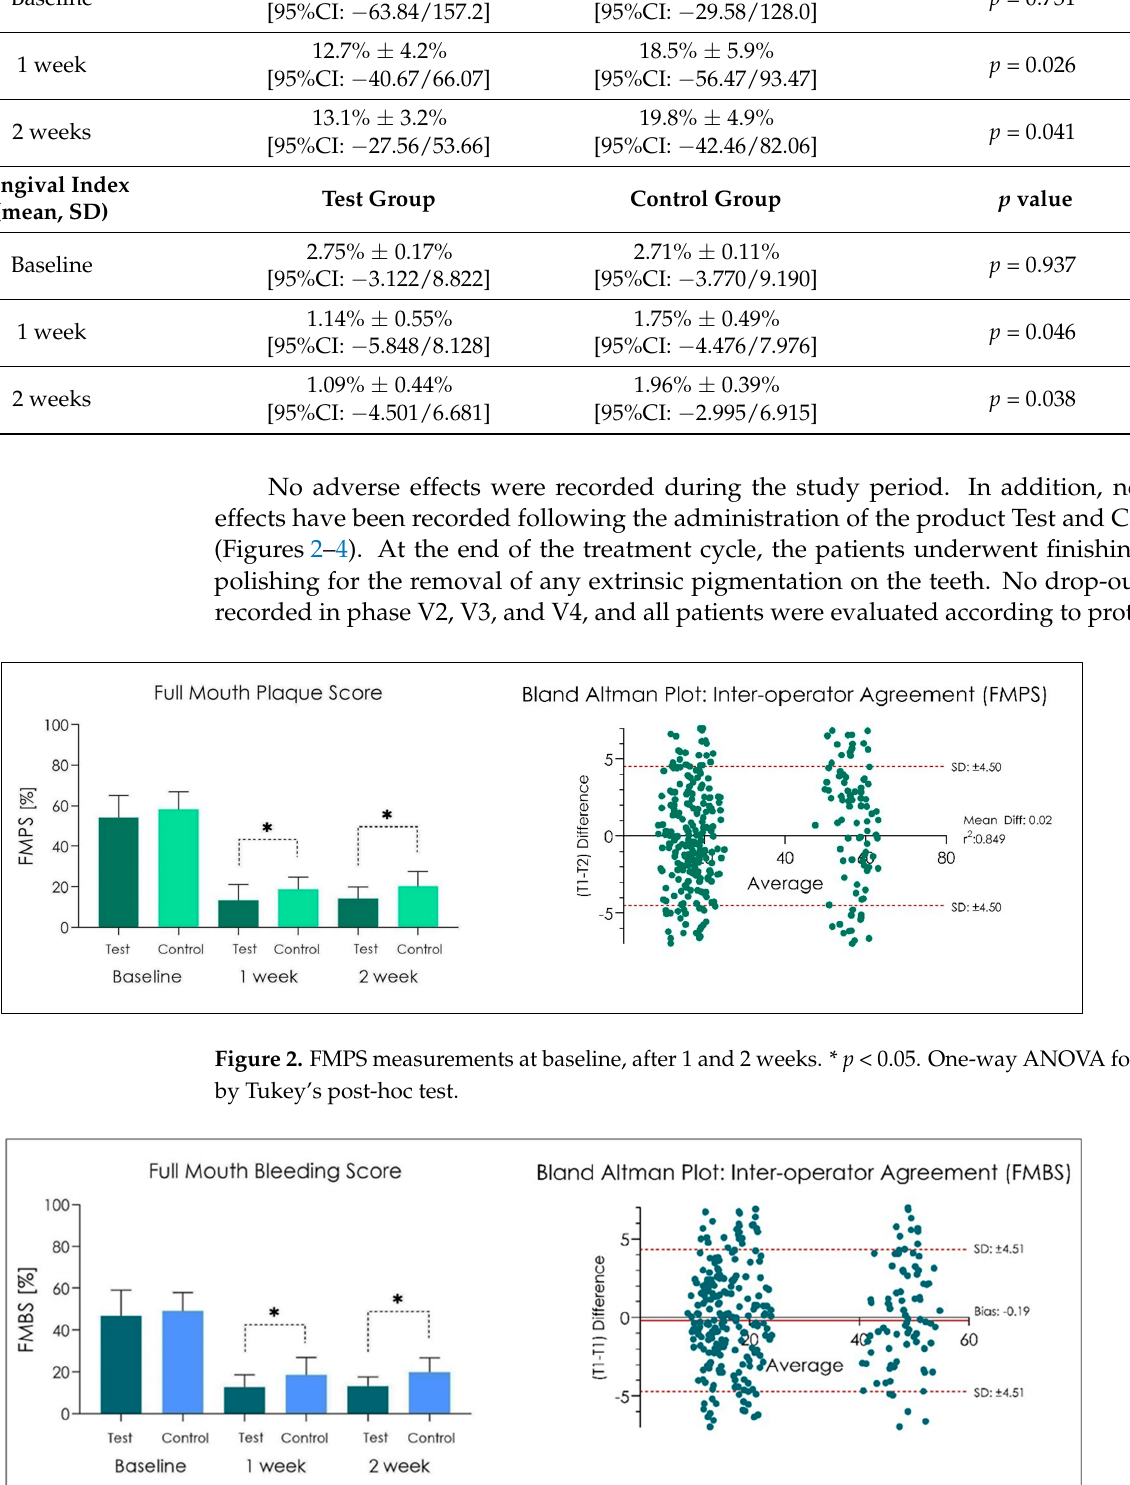
Figure 3. FMBS measurements at baseline, after 1 and 2 weeks. * p < 0.05. One-way ANOVA followed by Tukey’s post-hoc test.